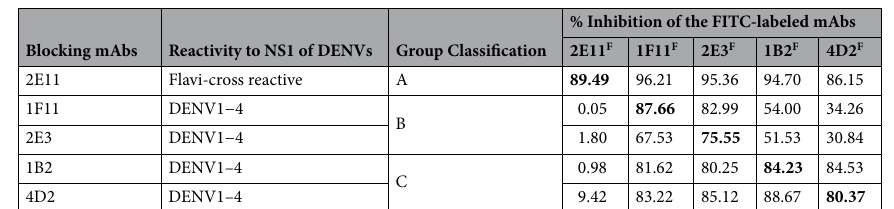
Table 1. Analysis of distinct binding epitope group of anti-NS1 mAbs by competitive binding ELISA. Interpretation of binding epitope between each pair of antibodies (blocking and FITC-labeled mAbs); Completely overlapping epitope: > 70% inhibition, Partial overlapping epitope: 20–70% inhibition, Discrete or non-overlapping epitope: < 20% inhibition. Bold values indicate self-blocking.